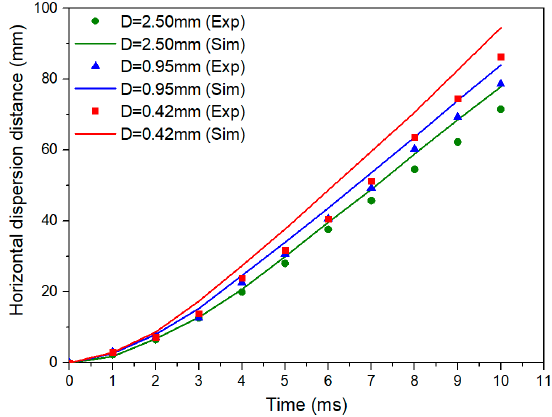
Figure 14. Particle horizontal dispersion distance at di ff erent times.